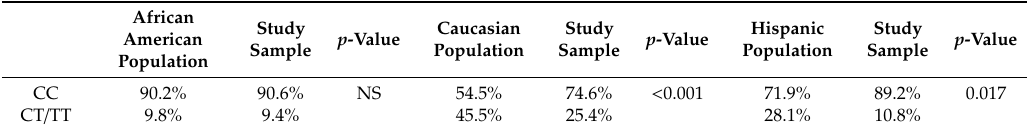
Table 3. Comparison of catalase SNP rs1001179 prevalence by race in the general population versus our study population.